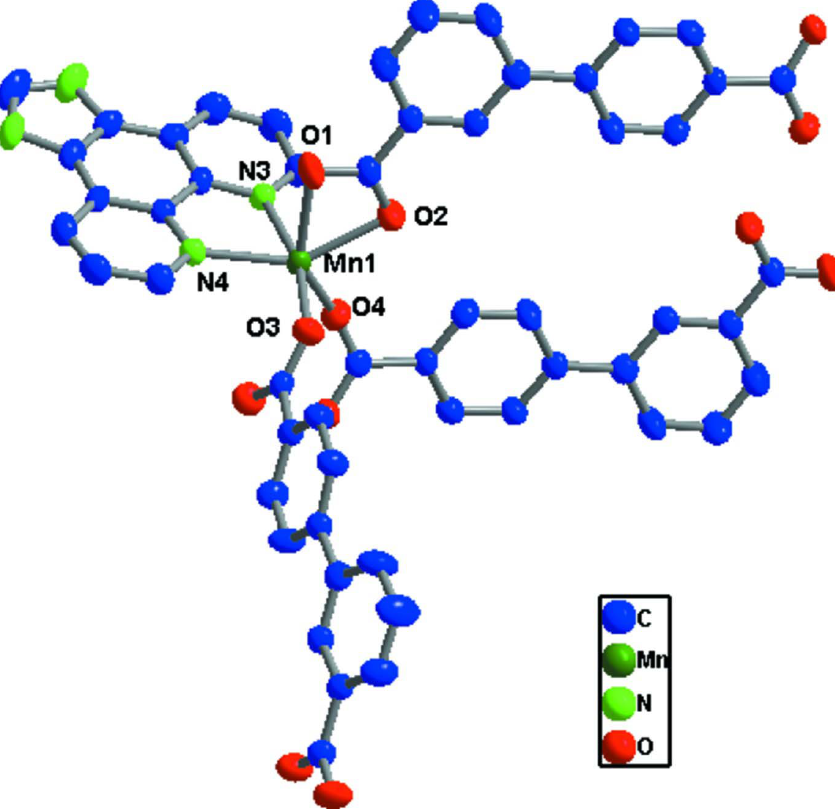
Figure 1 The coordination environments of manganese(II) atom. All hydrogen atoms are omitted for clarity.